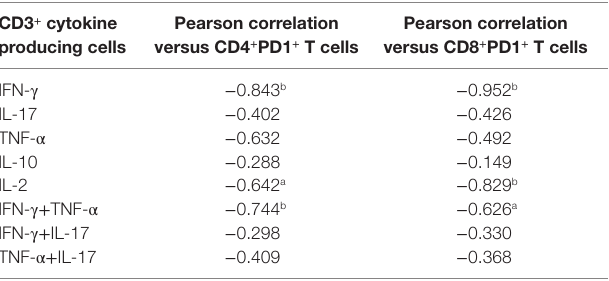
TaBle 3 | Pearson correlation of cD3 + T cell cytokine production with tumor infiltrating PD1 + T cells ( n = 11). Pearson correlation Pearson correlation cD3 + cytokine versus cD4 + PD1 + T cells versus cD8 + PD1 + T cells producing cells